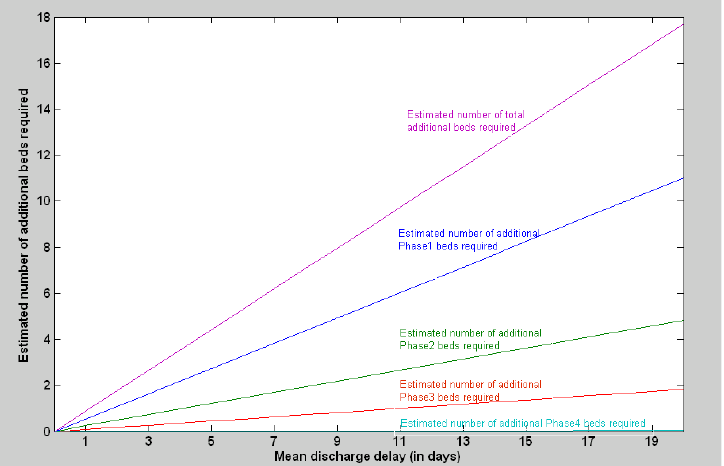
Figure 13. The estimated number of additional beds required in each phase of the stroke care unit with respect to the mean discharge delay (after 1000